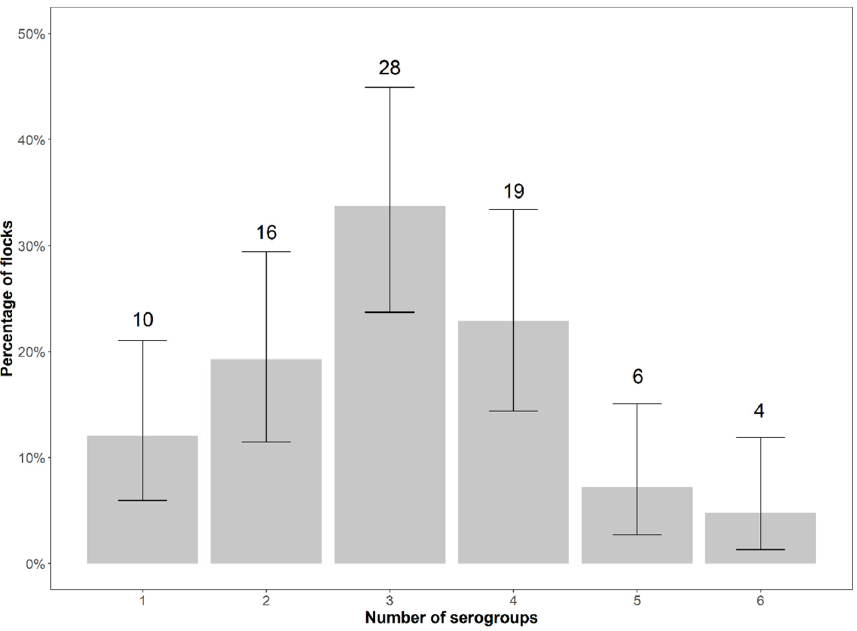
Figure 4. Number and percentage of flocks by number of serogroups detected in the flocks with exact binomial 95% confidence intervals.